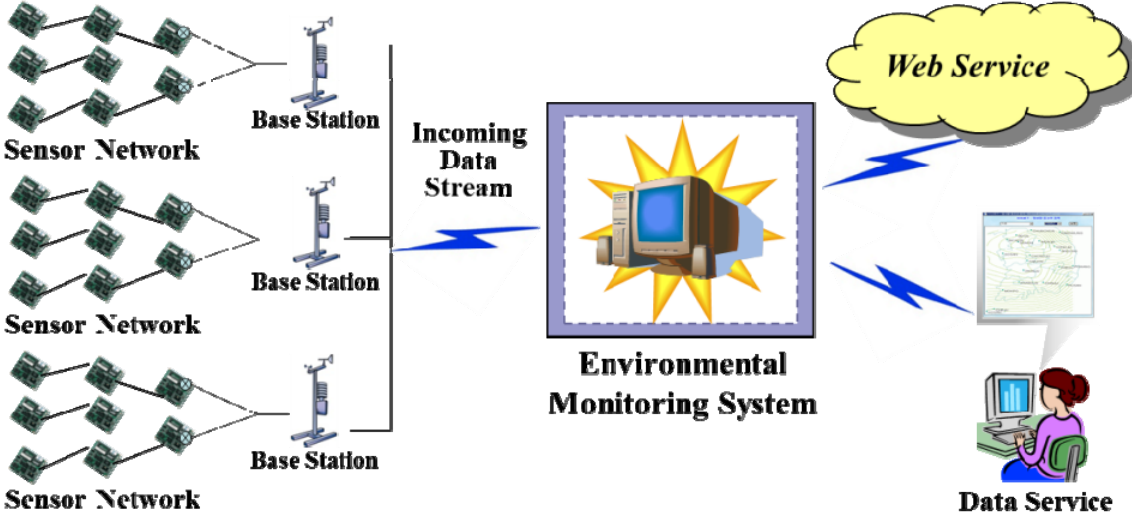
Figure 7. A generic view of applying sensor networks to environmental monitoring.